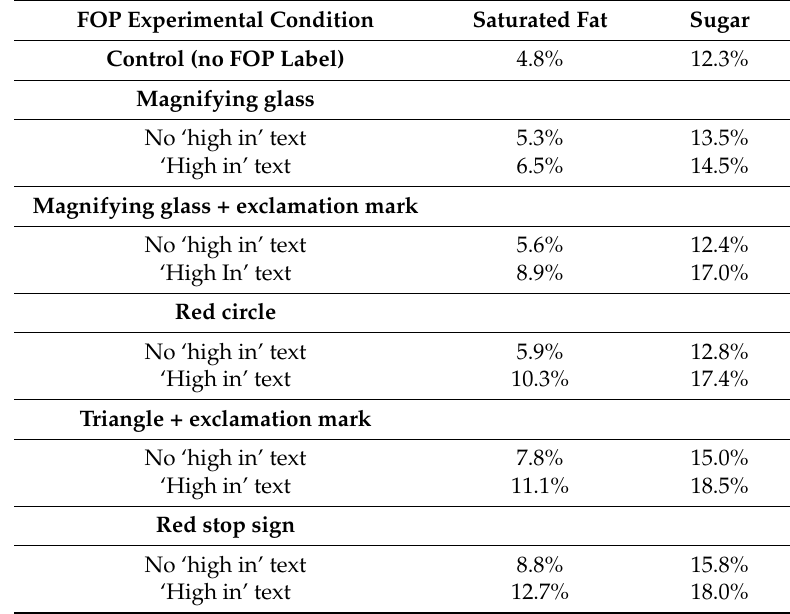
Table 2. Percentage of correct responses for each nutrient of concern by experimental condition * ( n =